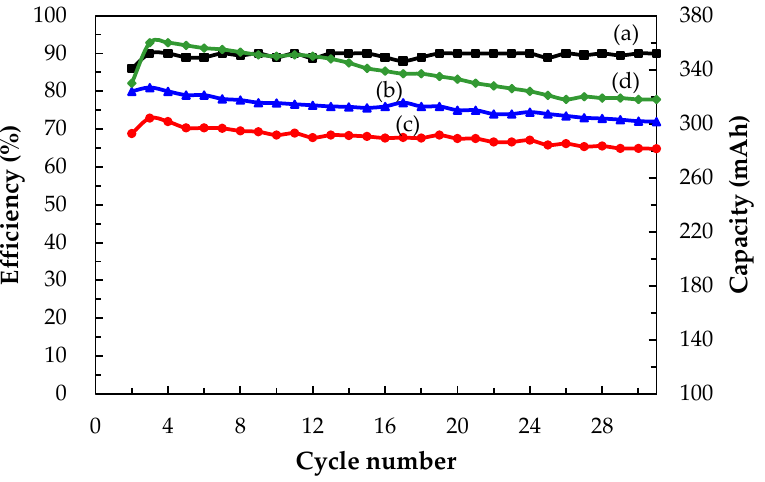
Figure 10. Cyclic efficiency and capacity in terms of ( a ) CE, ( b ) VE, ( c ) EE, and ( d ) discharge capacity of a Ce/ascorbic acid/I RFB system with modified N-117 – SiO 2 – SO 3 H as the separation membrane and staggered-type flow channels, 1.0 M Ce(NO 3 ) 3 /2.0 M CH 3 SO 3 H as a positive electrolyte, 1.0 M I 2 /0.25 M ascorbic acid/2.0 M H 2 SO 4 as a negative electrolyte, and C – TiO 2 – PdO composite electrodes as positive/negative electrodes at a current density of 20 mA/cm 2 and 20 mL of electrolyte solutions.